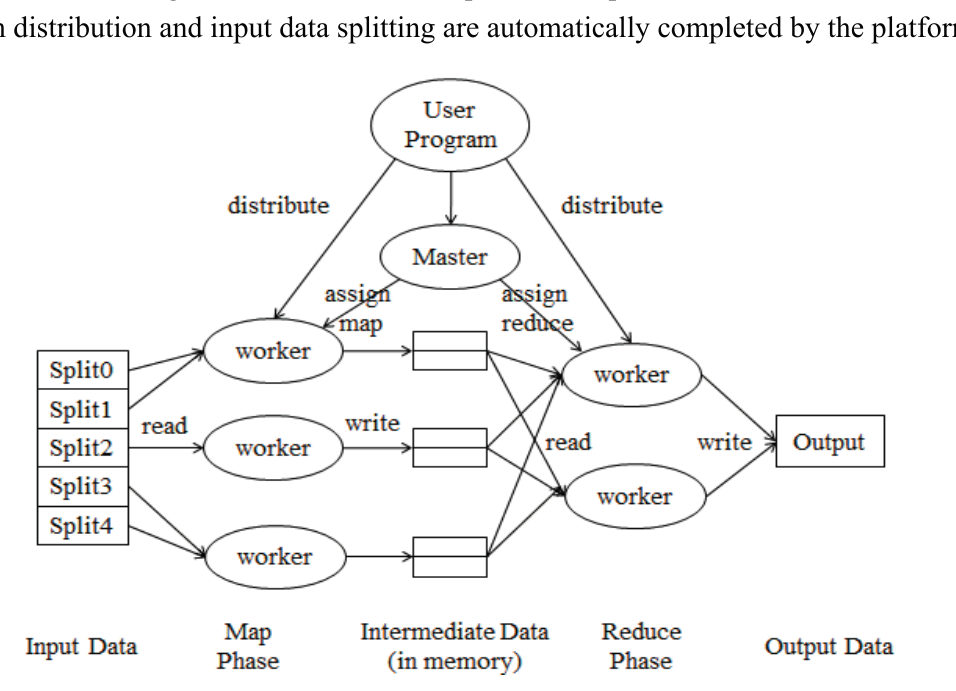
Figure 2. The working principle of